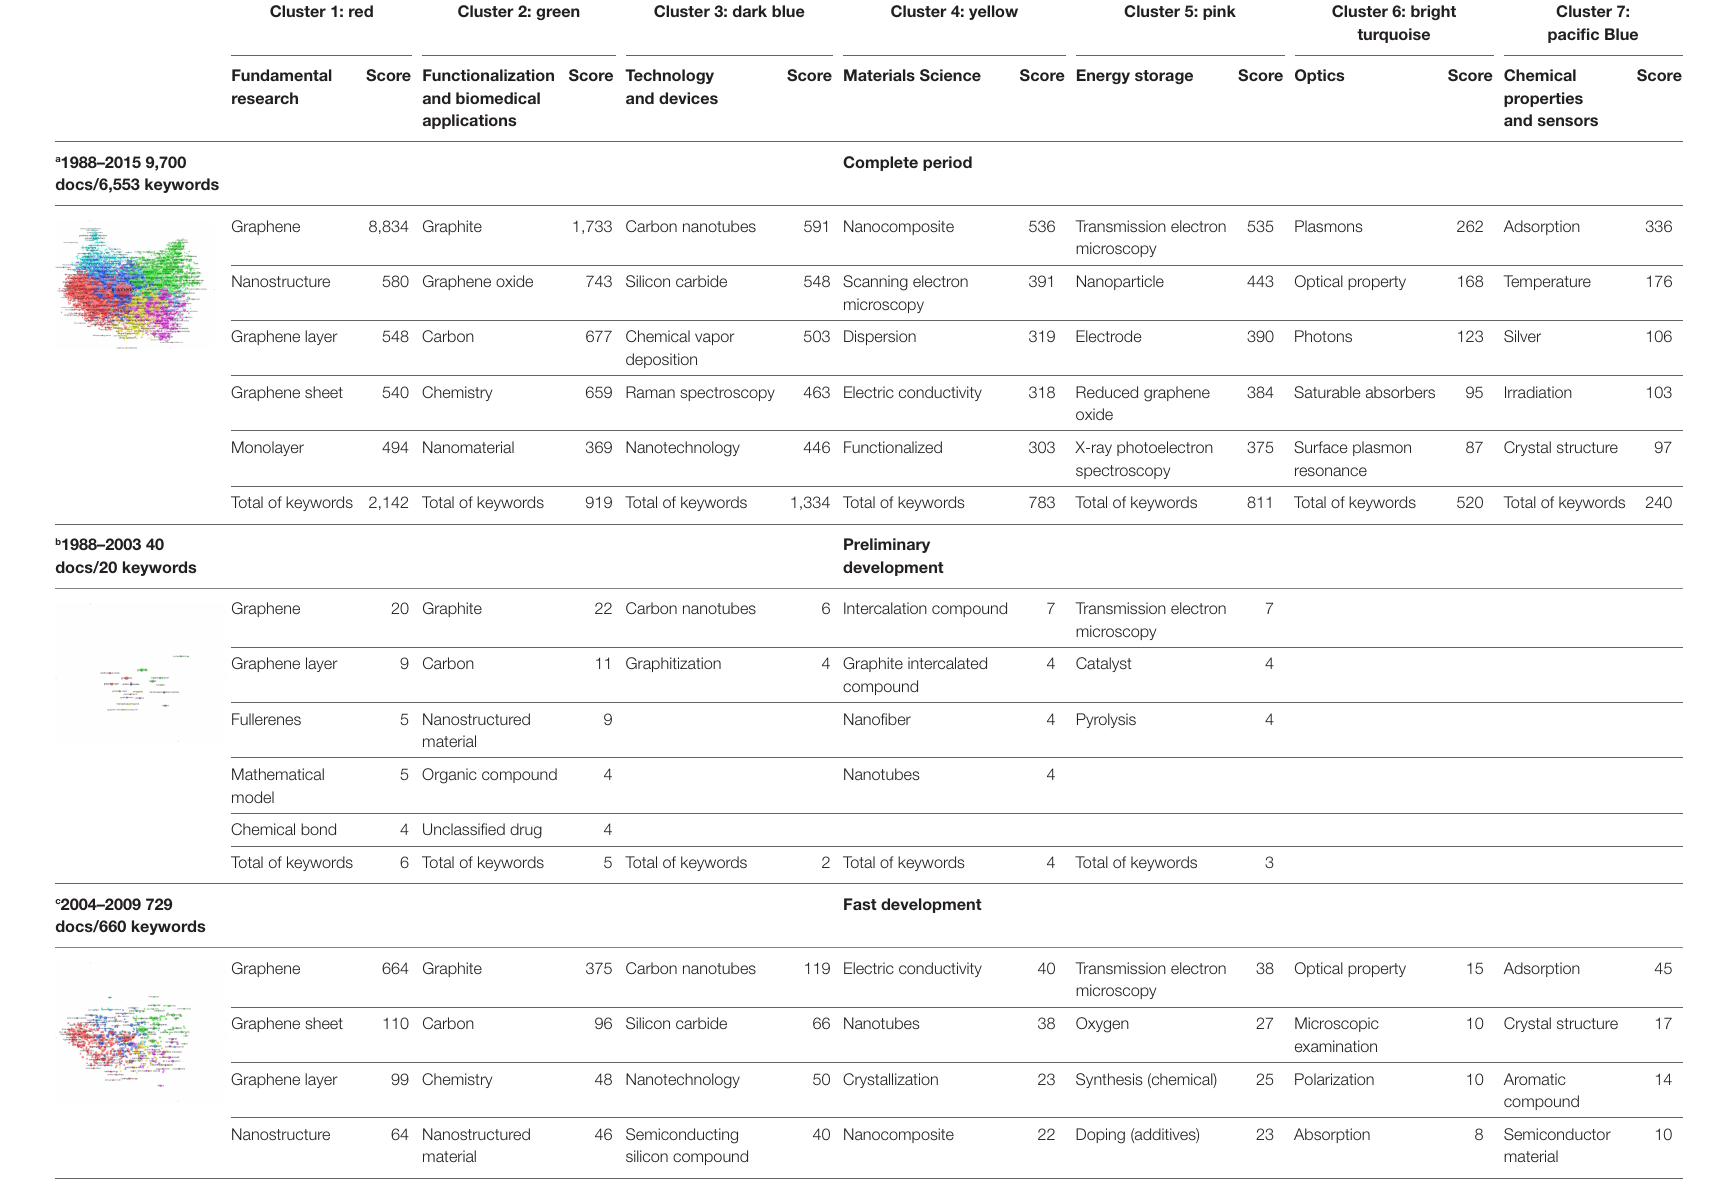
TaBle 6 | Intellectual structure of graphene research and its evolution in Europe